Question: Generate an informative caption for the figure above.
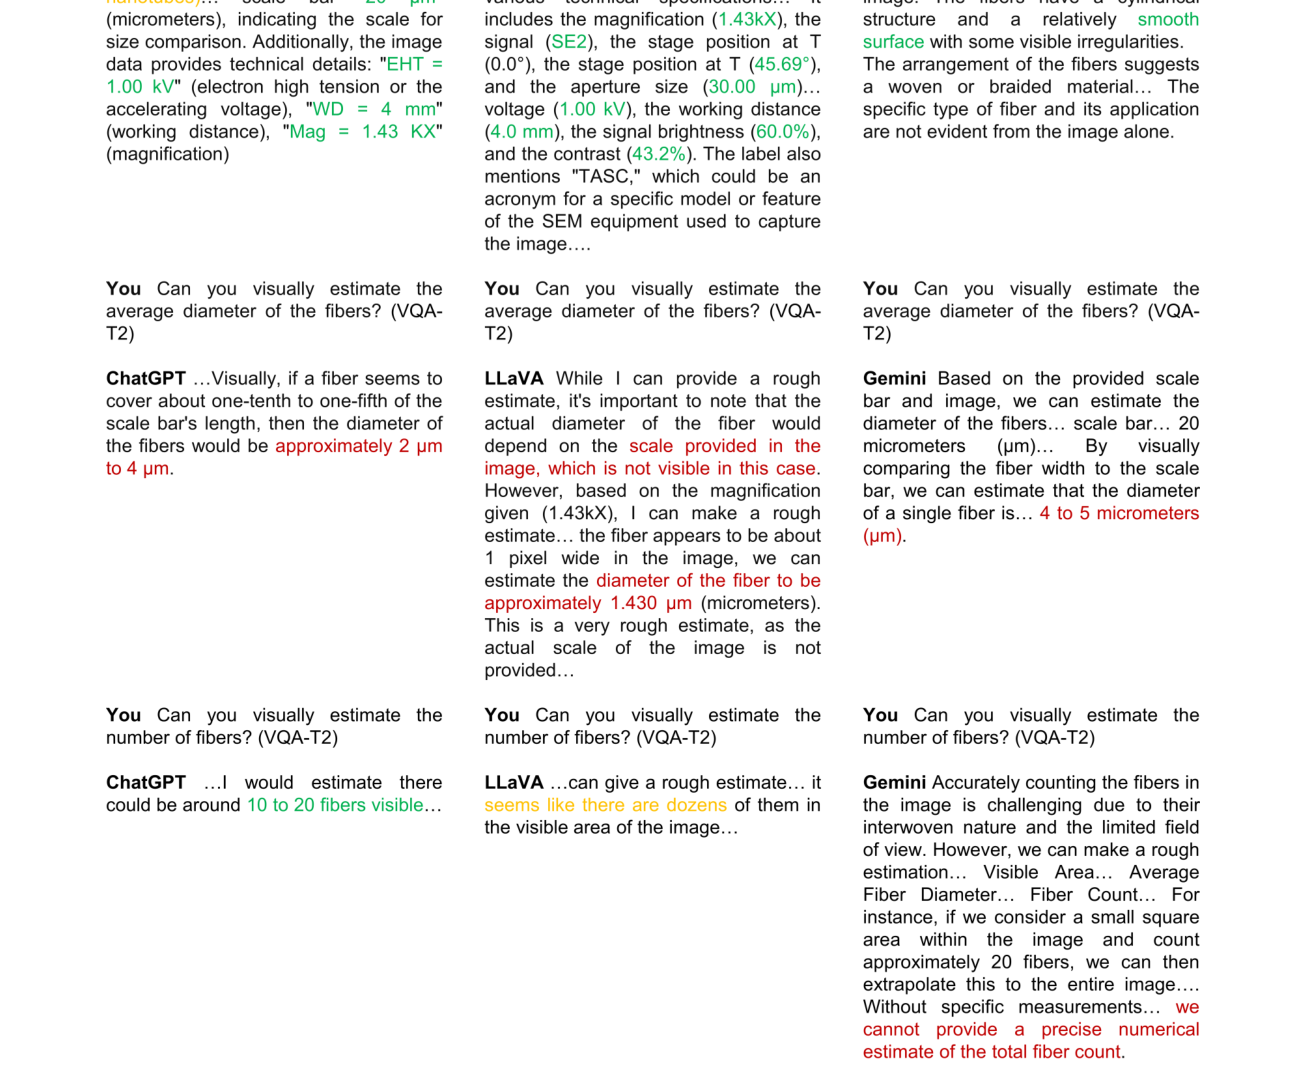
Answer: Performance of ChatGPT, LLaVA, and Gemini (left to right) on VQA tasks of describing an image of fibers and estimating the number and average diameter of fibers. Correct key responses are colored in green, wrong responses in red, and mixed or uncertain in orange. Extraneous information has been replaced with ellipses.